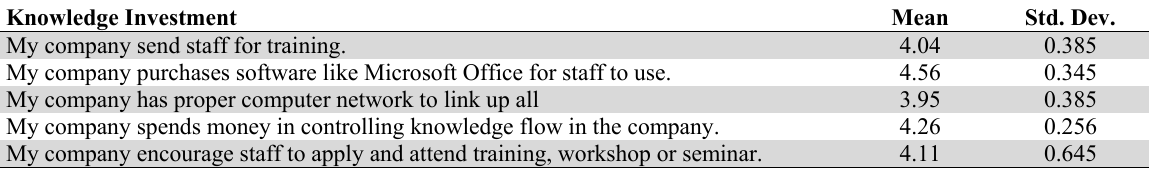
Mean and Standard Deviation for “Knowledge Investment” Knowledge Investment Mean Std. Dev.